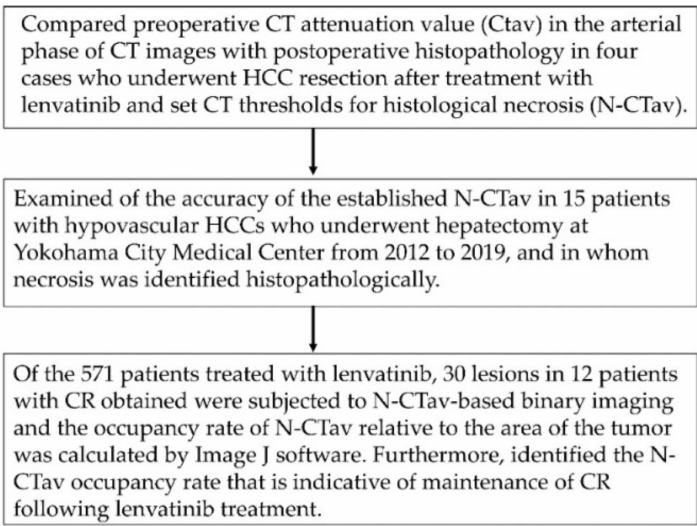
Figure 1. Flow chart showing the study methodology. CT, computed tomography; HCC, hepatocellu- lar carcinoma; Image J software (IJ1.46r), Image Processing and Analysis in Java